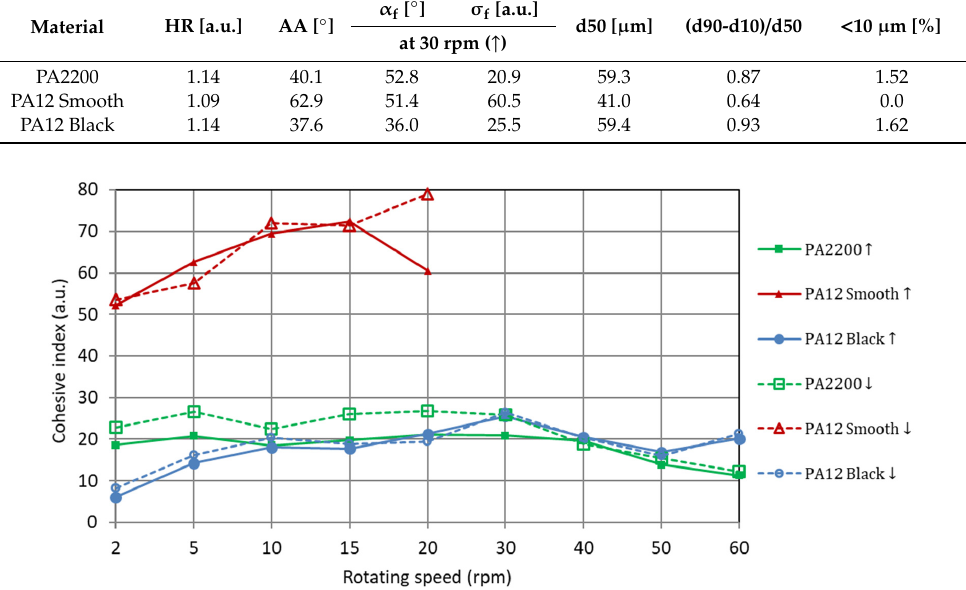
Figure 3. Cohesive index curves recorded as a function of the increasing ( ↑ ) and decreasing ( ↓ ) rotation speed for polyamide powders.